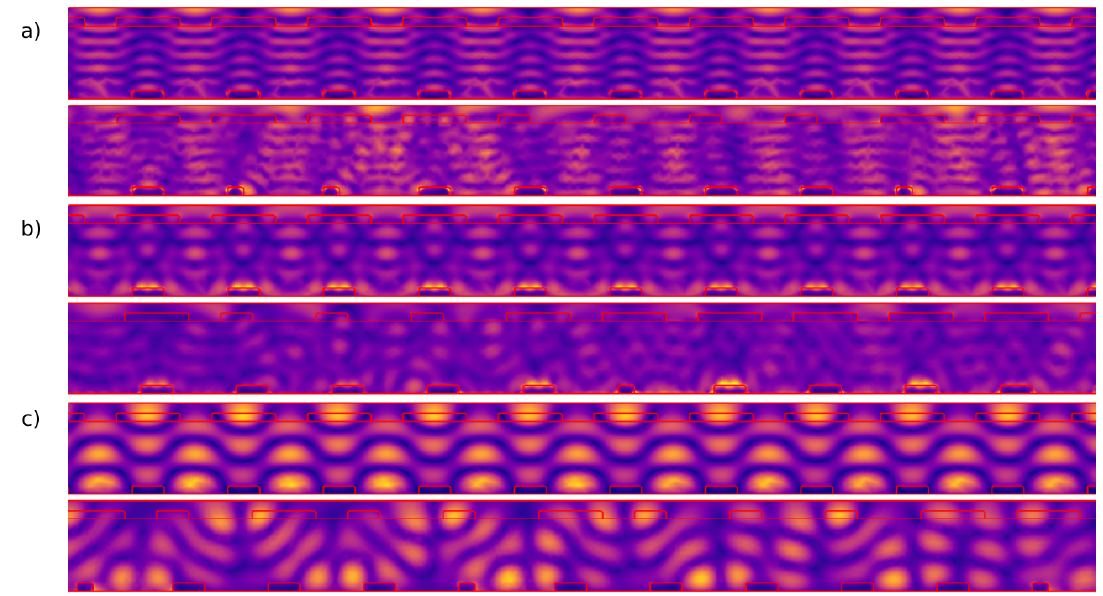
Figure 12. simulated electric field distributions at different operating wavelengths of ( a ) 583 nm; ( b ) 764 nm; and ( c ) 1014 nm highlighted in Figure 11, for solar cell topologies with a periodic double grating (top) and an optimized semiperiodic double grating